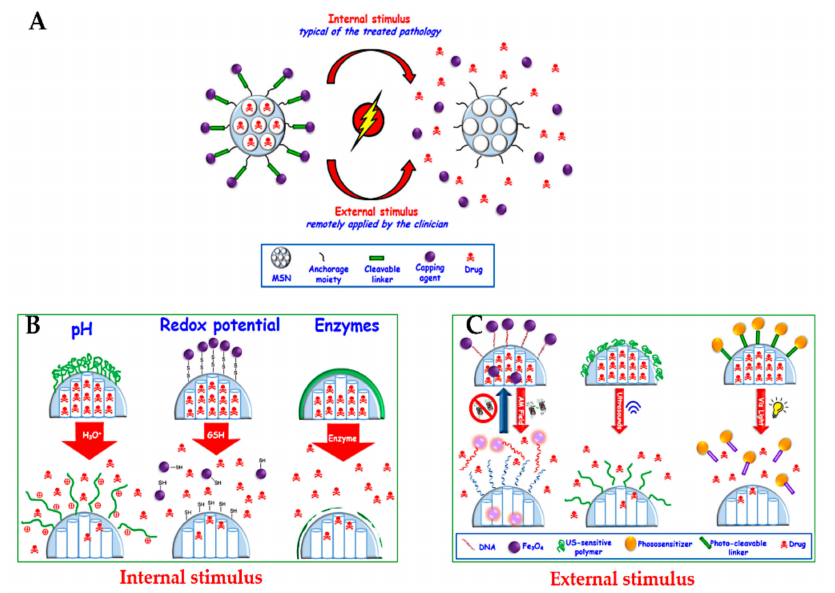
Figure 14. ( A ) Schematic representation of stimuli-responsive release of drugs from MSNs. ( B ) In- ternal stimuli-responsive release. ( C ) External stimuli-responsive release. Reproduced from [81], MDPI,